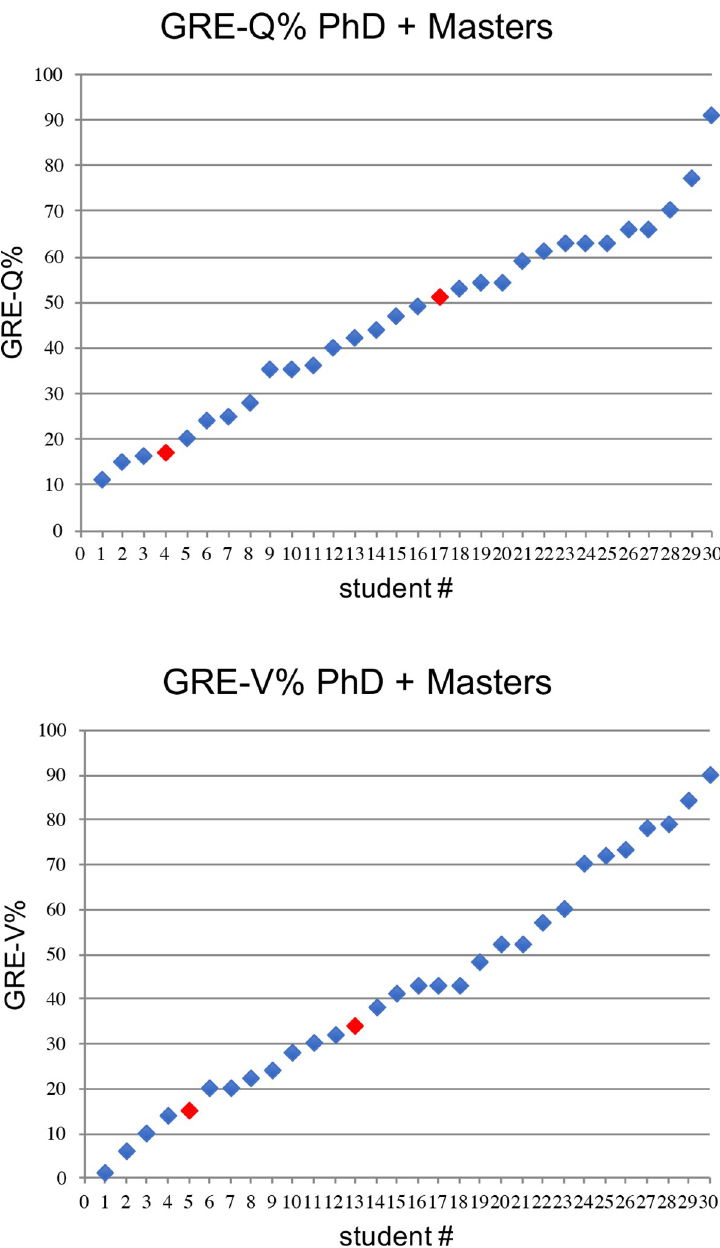
Fig 1. GRE Quantitative and verbal scores of IMSD students matriculating from 2007–11 who completed a PhD or a Master’s degree. Top panel depicts GRE-Q% and lower panel depicts GRE-V% for 30 students who completed either a PhD (blue symbols) or Master’s degree (red